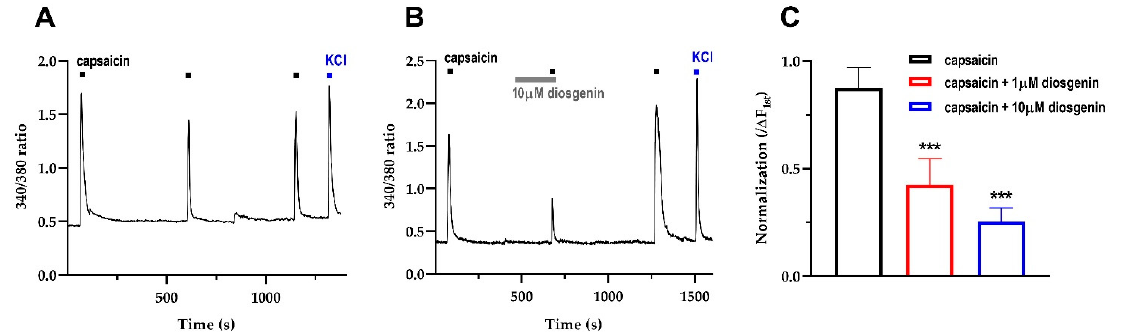
Figure 3. Capsaicin induces an influx of extracellular Ca 2+ in mouse DRG sensory neurons. ( A ) Capsaicin (100 nM) produces consistent [Ca 2+ ]i responses (intervals of 9 to 11 min). ( B ) Pretreatment with 10 µ M diosgenin reduces capsaicin-induced [Ca 2+ ]i in mouse DRG. ( C ) Mean [Ca 2+ ]i responses normalizes to the peak amplitude of the first capsaicin response (n = 6, n = 4, n = 14, respectively). Neuronal cell viability is confirmed based on the response to 50 mM KCl solution (blue, 10 s) at the end of the experiment. Results are presented as mean ± standard error of mean/ *** p < 0.0001 Dunnett’s test following one-way ANOVA versus the capsaicin group. DRG: dorsal root ganglion; [Ca 2+ ]i: intracellular free calcium.